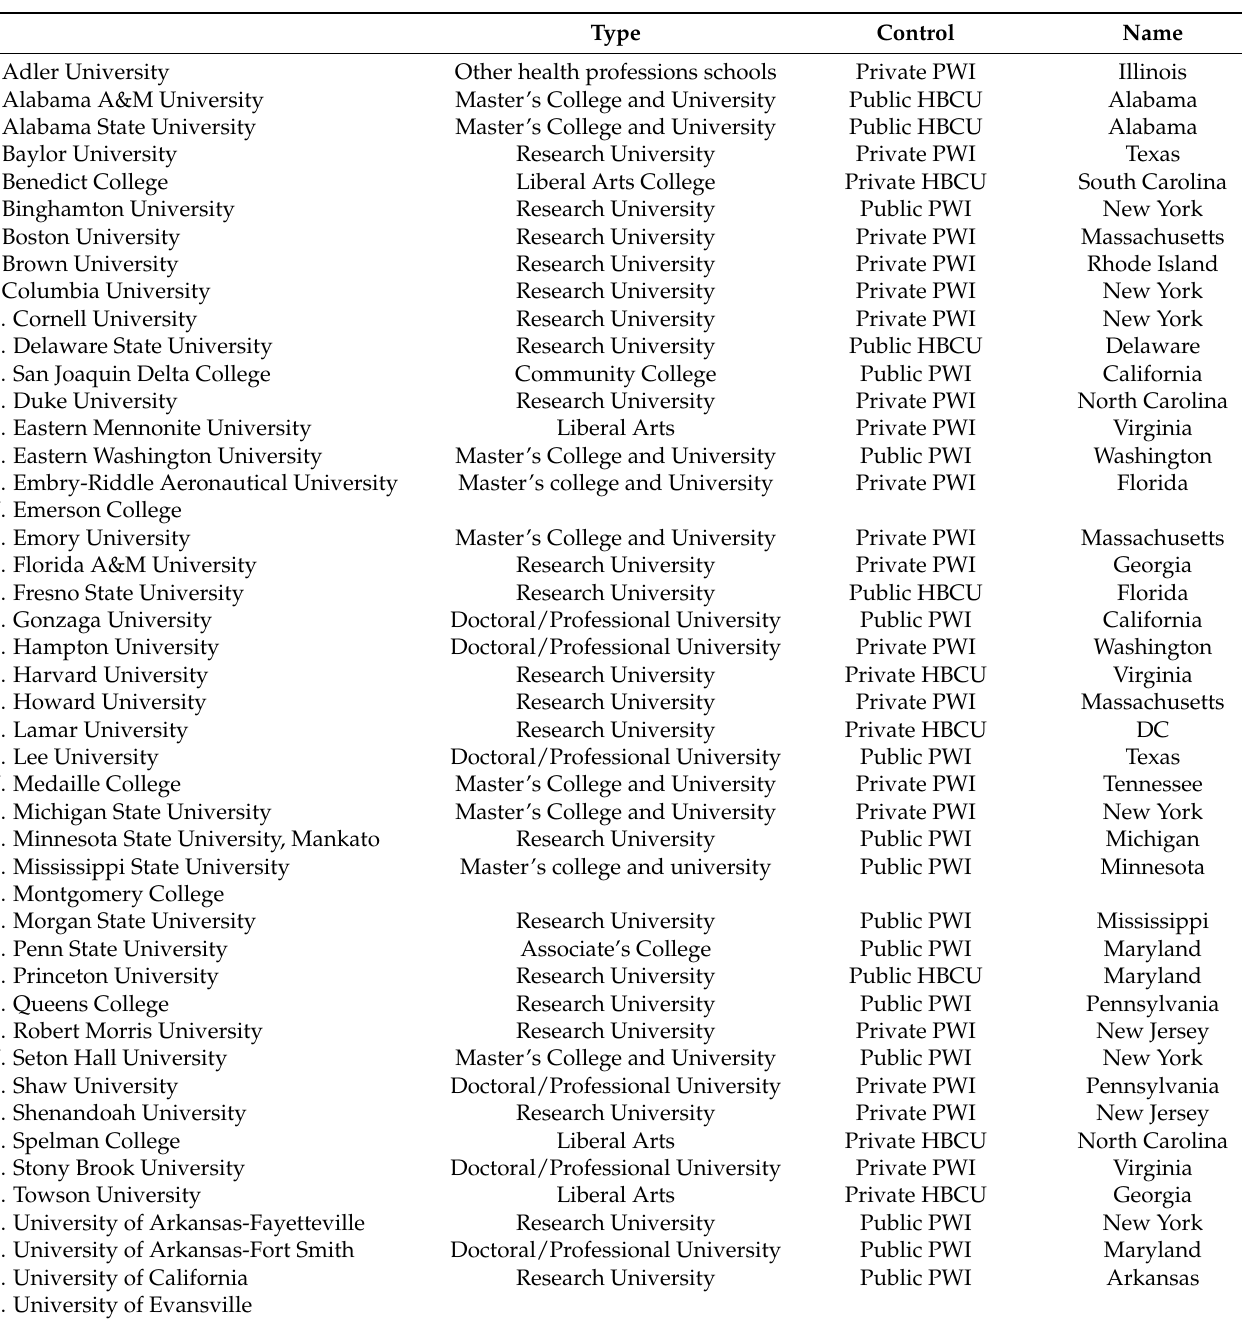
Table A1. Sample of Universities by